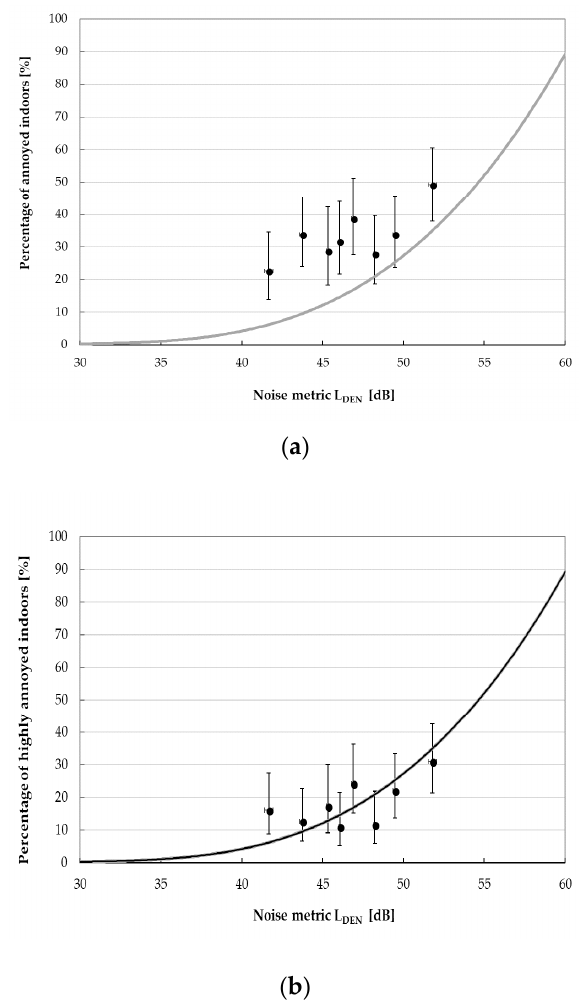
Figure 12. Comparison of observed proportions (with 95% confidence levels) of respondents being ( a ) annoyed and ( b ) highly annoyed indoors by the wind turbine noise to exposure-response relationships for wind turbine annoyance outdoors proposed by Janssen et al. Dots with whiskers represent survey data with 95% confidence intervals.